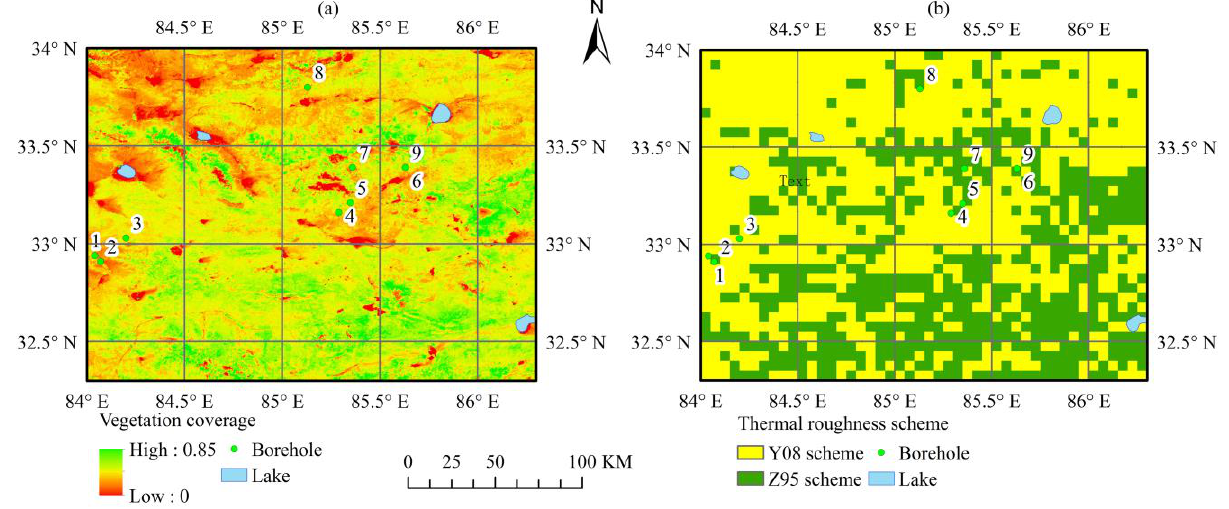
Figure 4. Distribution of ( a ) vegetation coverage and ( b ) thermal roughness scheme in the Gaize area (Borehole number 1 to 9 correspond to the borehole ID in Table 1).